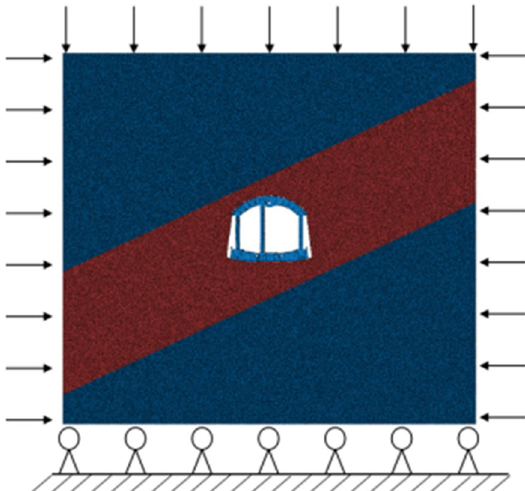
Figure 10. Synergistic system model.